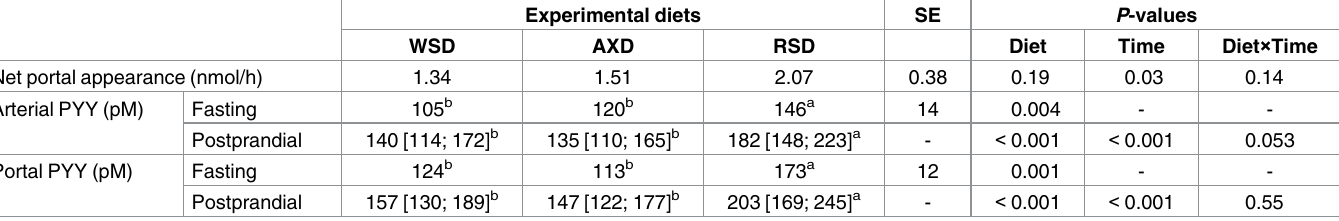
Table 2. Postprandial net portal PYY appearance and mesenteric arteryand portal vein PYY concentrations of pigs fed WSD, AXD, and RSD.